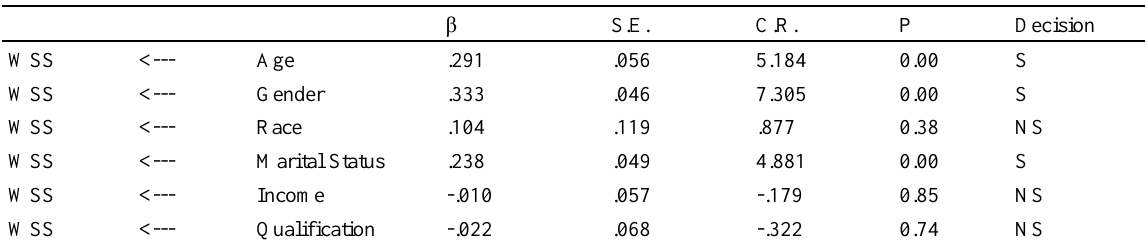
Table 4: p-values showing the significant influence of demographic variables on work stimulated stress among preschool